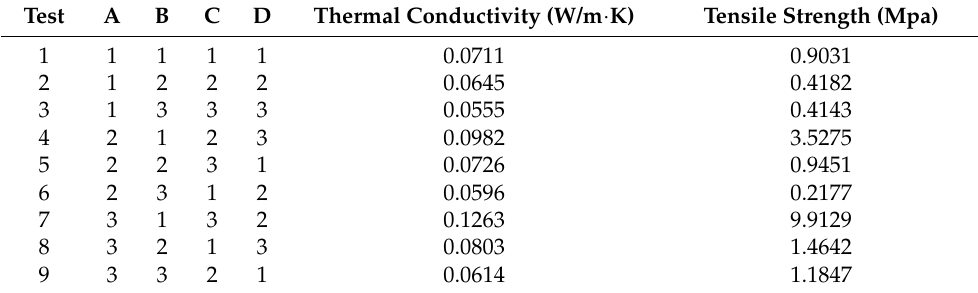
Table 4. Orthogonal scheme and its